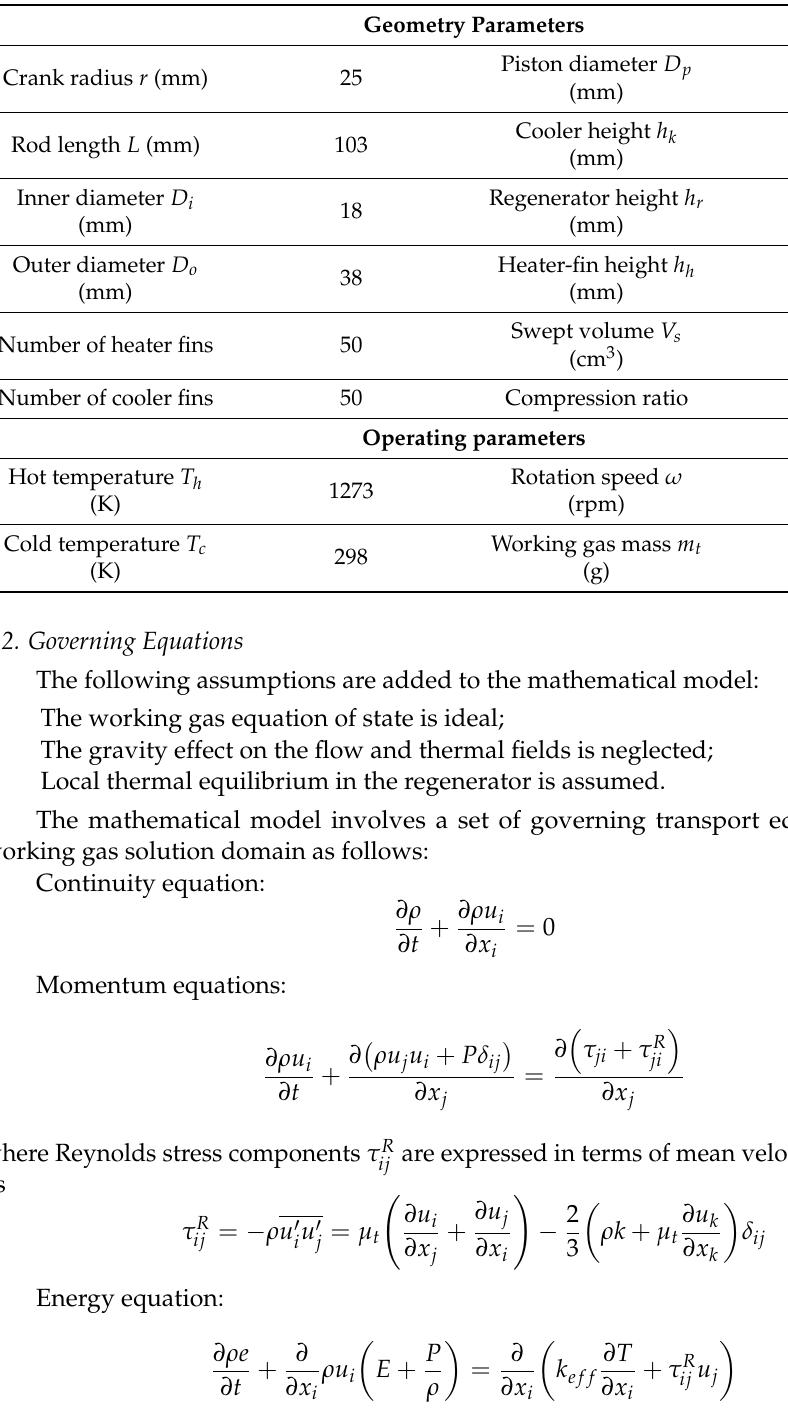
Table 1. Prototype thermal-lag engine